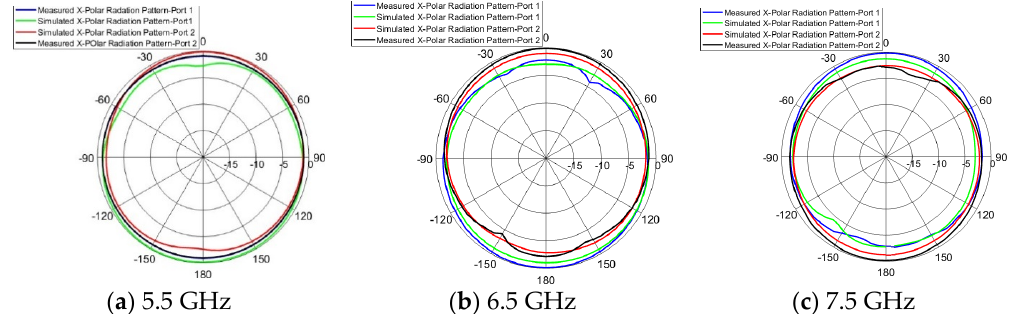
Figure 14. Simulated and measured cross-polar ( E φ ) radiation patterns ( θ -cut at φ = 90) at 5.5, 6.5, and 7.5 GHz for Ports1 & Port